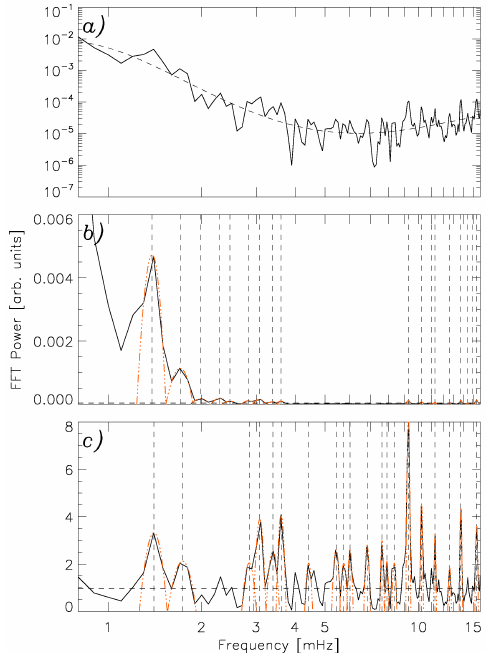
Fig. 5. Panel (a) shows the average spectrum of the compressional magnetic field component for 24 October 2004 in double logarith- mic space. The dotted line shows the fitted 4th order polynomial. Panel (b) shows the same spectrum on a linear y-axis. Peaks found in the untreated spectra are marked by vertical dashed lines. See text for further